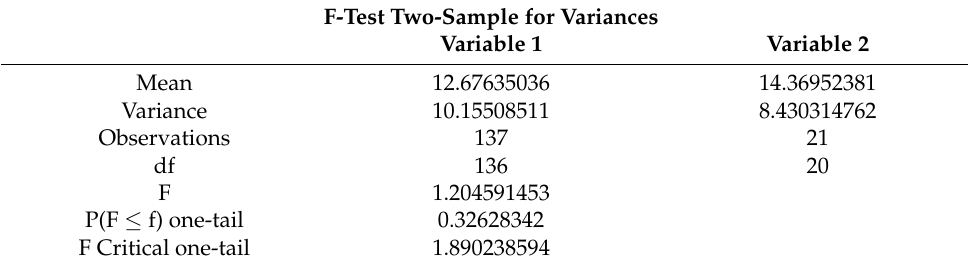
Table 3. Results of F-Test for